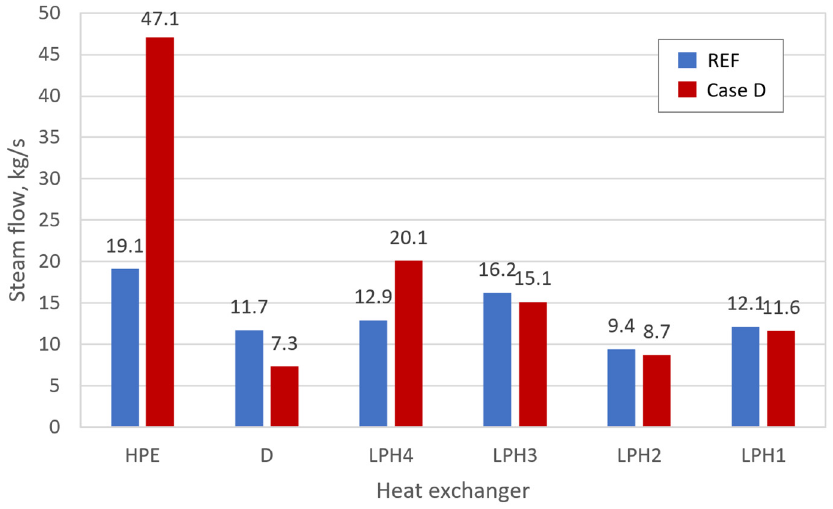
Figure 14. Steam mass flow rate to the feed-water heaters (heat exchanger labels as shown in Figure 5).